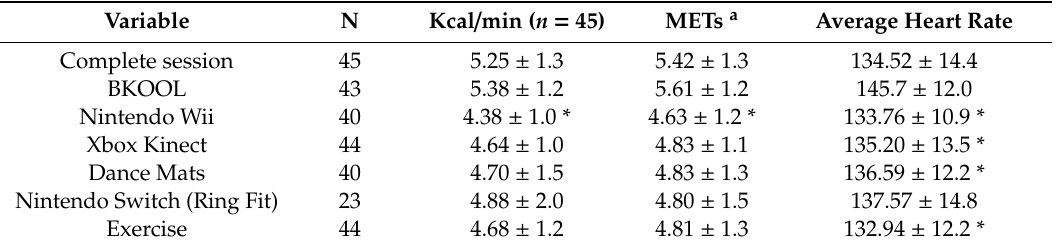
Table 2. Energy expenditure for the whole session, each AVG a , and exercise without AVG a